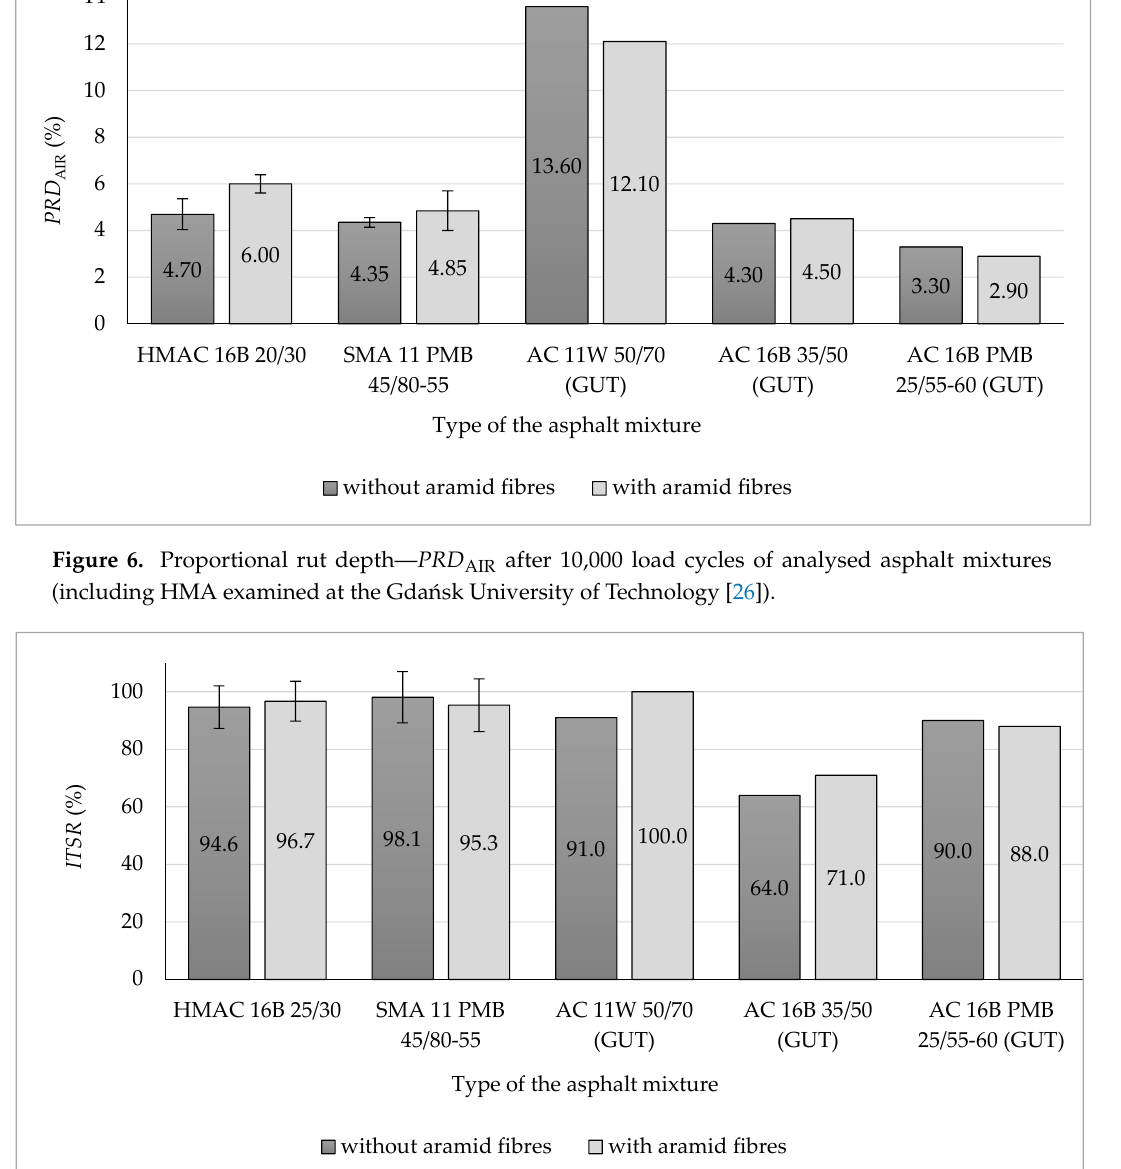
Figure 7. Indirect tensile strength ratio ITSR of analysed HMA (including HMA examined at the Gdańsk University of Technology [26]).